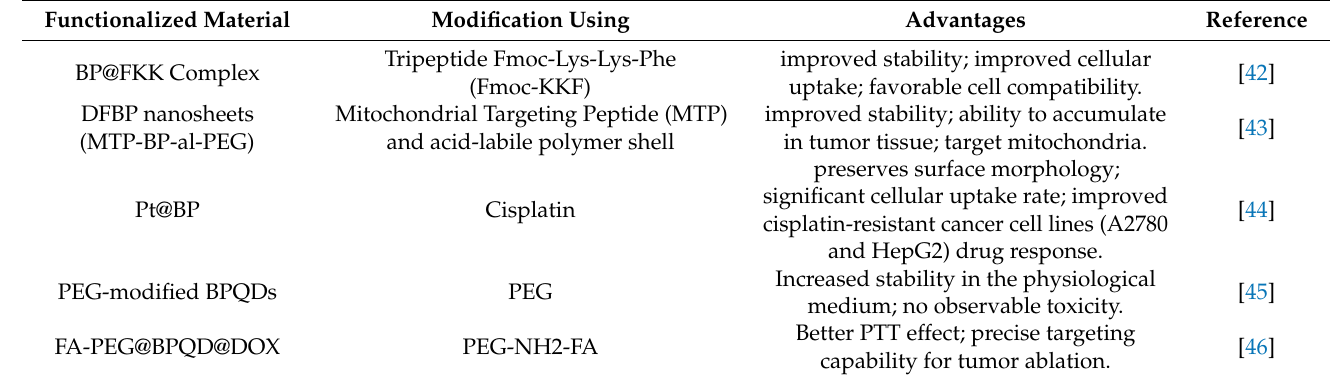
Table 2. Surface modification of BP and its